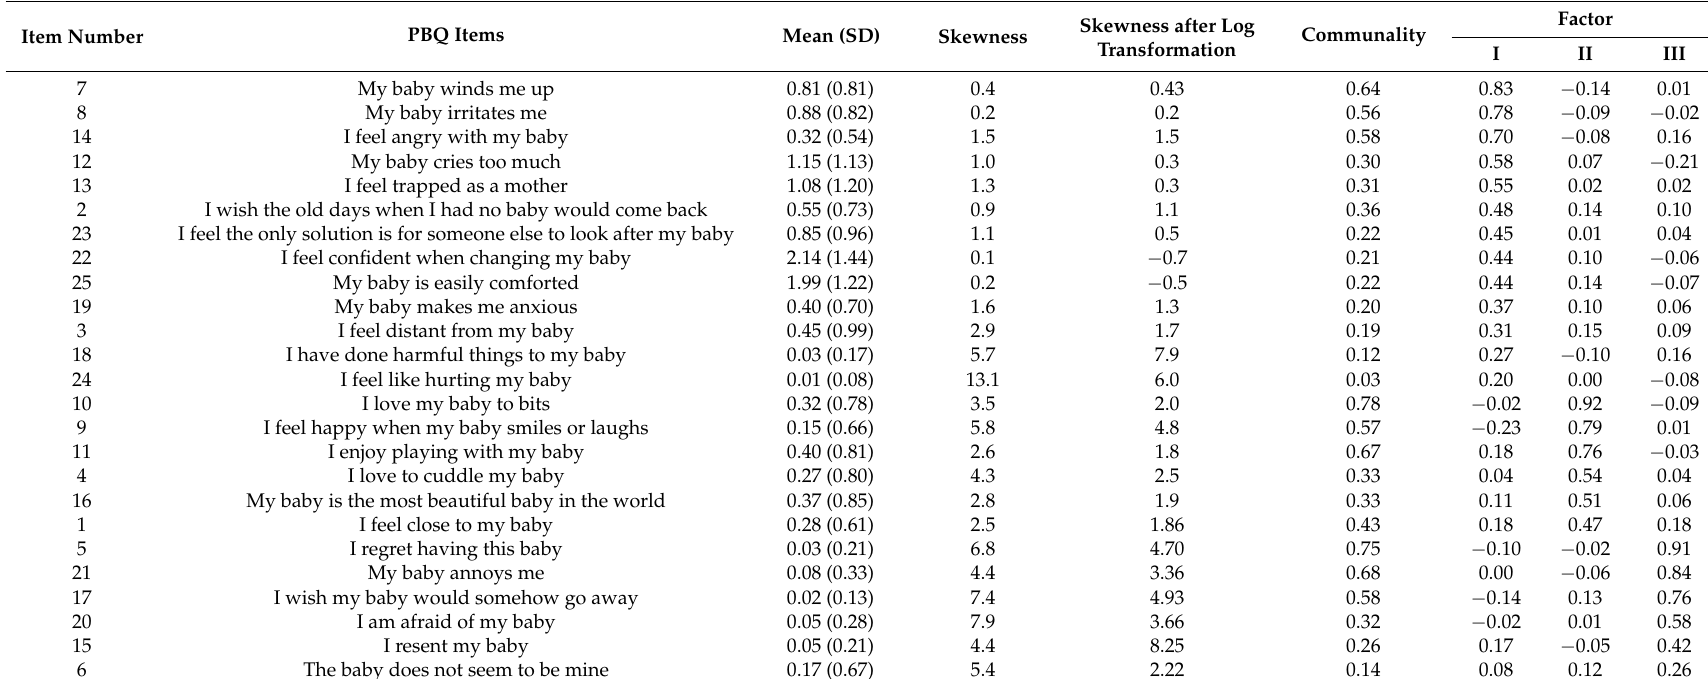
Table 1. Exploratory factor analysis of the PBQ items in a split-half sample ( n =